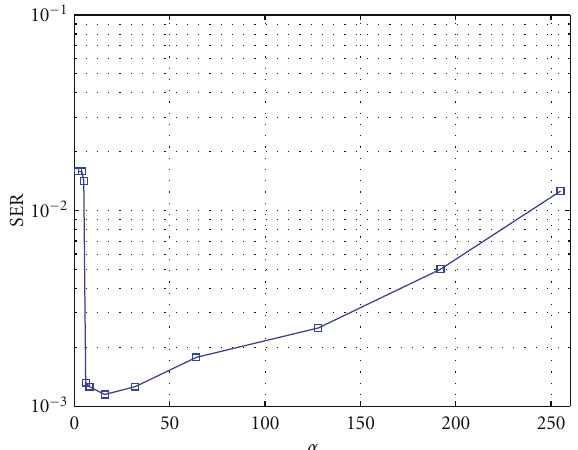
Figure 8: CEQTR SER × α , where α = α max = 1 /p 0 (see Table 3). “Brazil A” profile with 150 Hz Doppler rotation and SNR = 20dB.